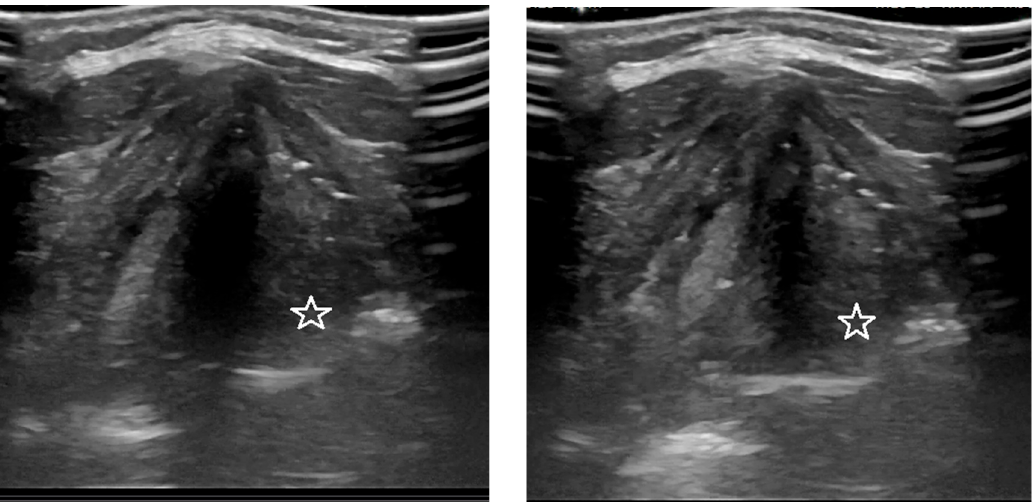
Figure 2. Asymmetry of the glottis during breathing on ultrasound. Reduced mobility and adduction of the left vocal fold (asterisk).